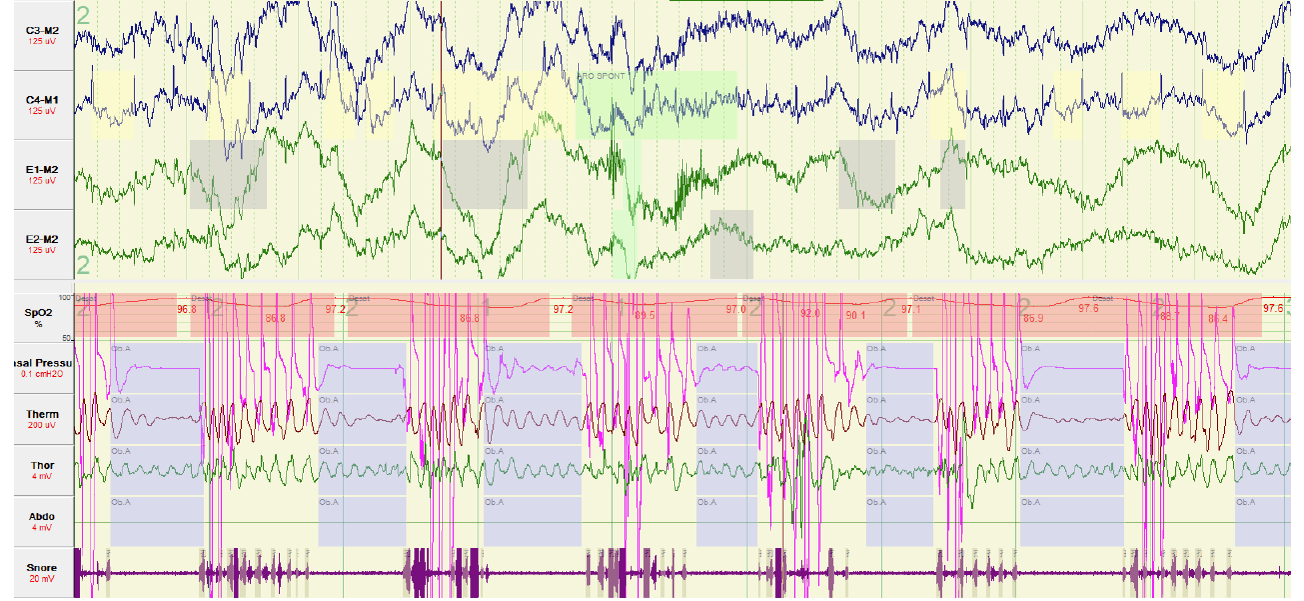
Figure 1. A demonstration of the EEG signals collected by the PSG device.